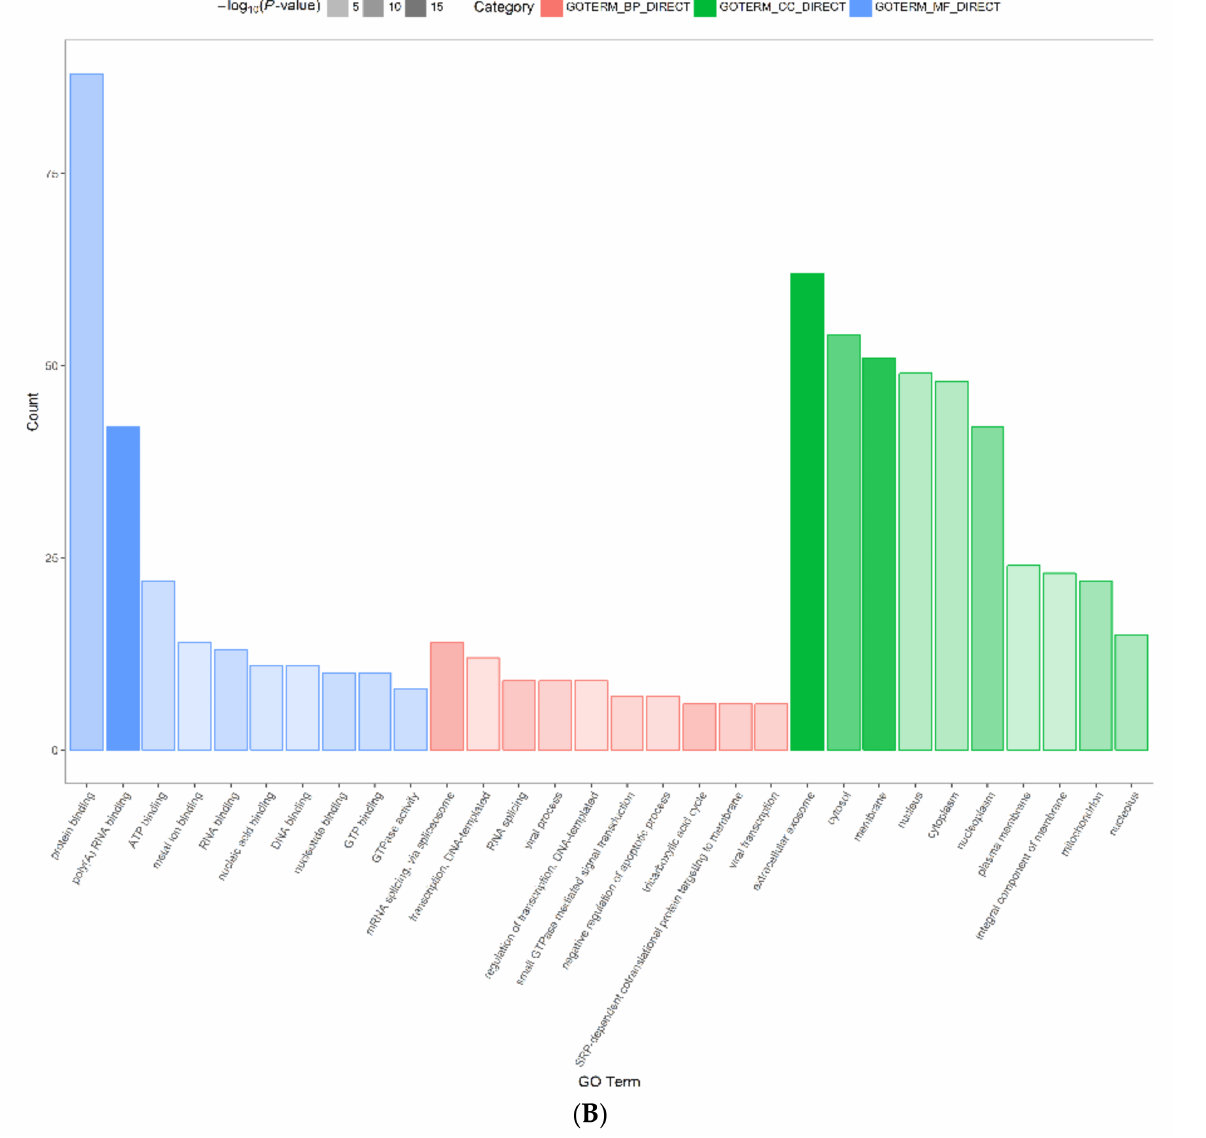
Figure 3. Gene ontology analysis of differentially expressed proteins. ( A ) Ethanol group versus control group; ( B ) flavonoids group versus ethanol group. GOTERM (GO)_MF (blue column) represents molecular function; GOTERM (GO)_CC (green column) represents cellular component; GOTERM (GO)_BP (pink column) represents biological